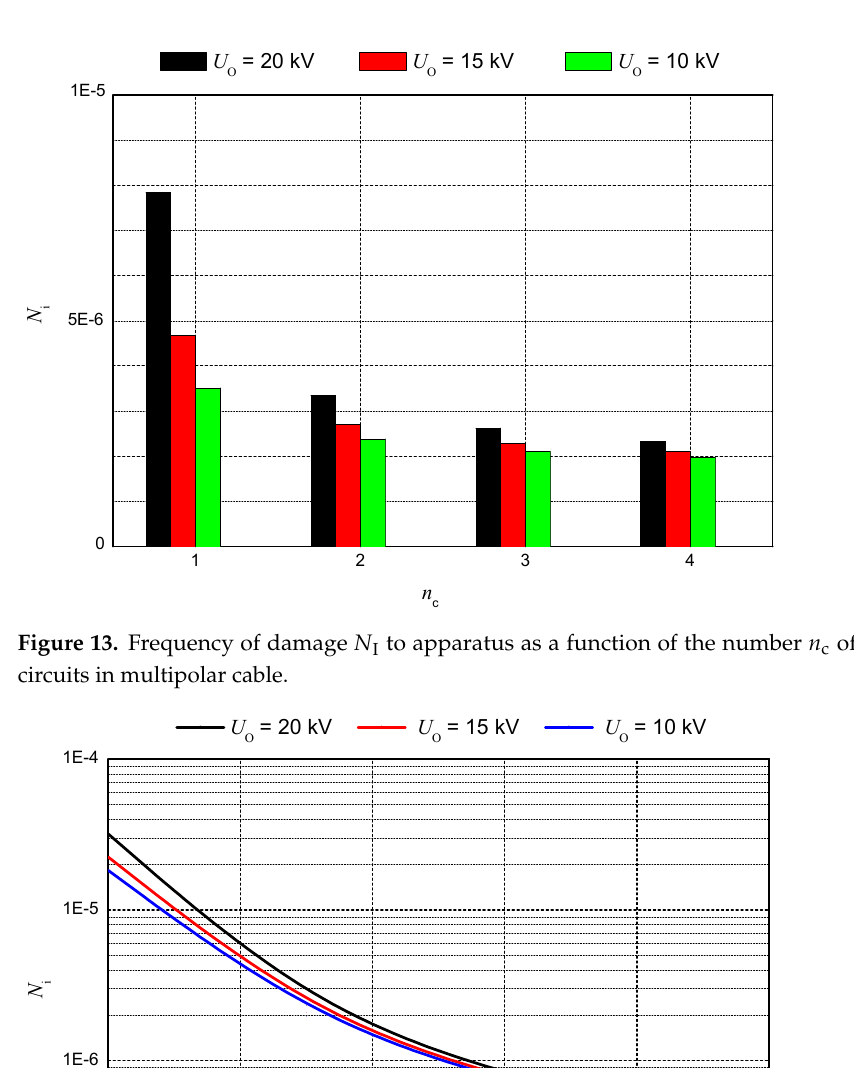
Figure 11. Frequency of damage N I to apparatus as a function of the number n c of connected LV circuits in conduit.